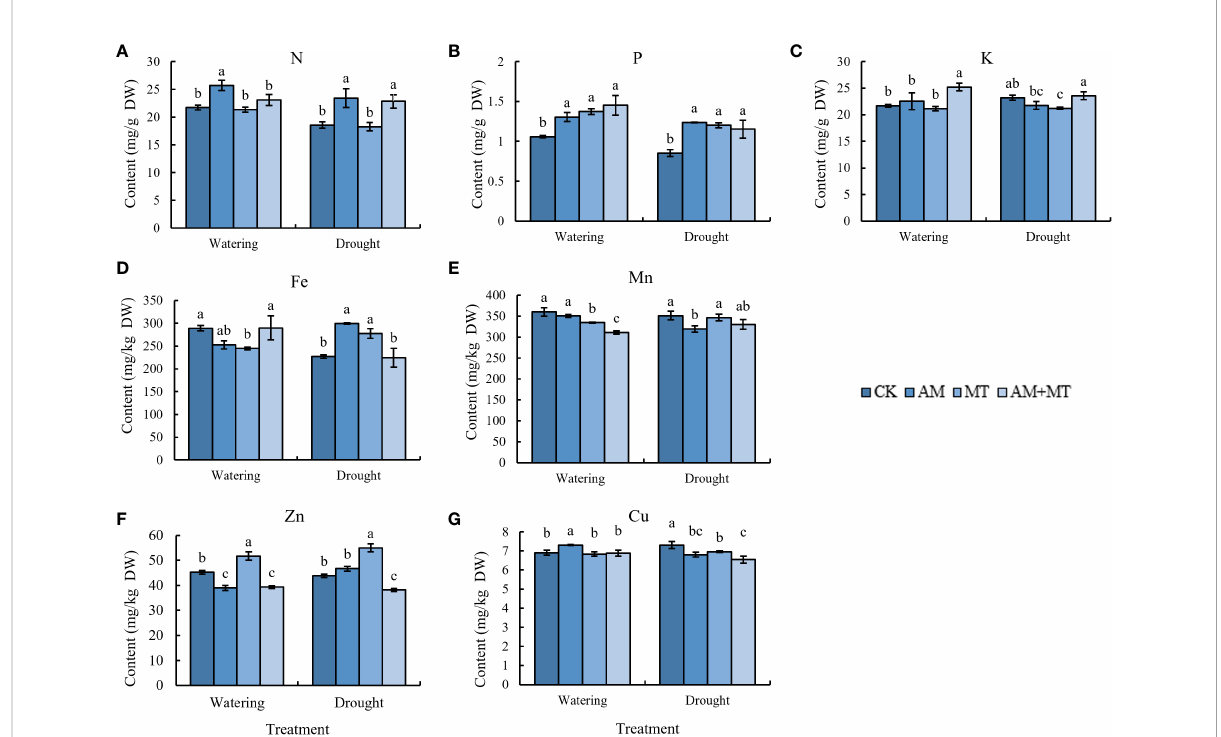
FIGURE 8 Content of N (A) , P (B) , K (C) , Fe (D) , Mn (E) , Zn (F) , and Cu (G) in leaves of kiwifruit seedling under well-watering or drought stress. Data are presented as meant ± SD ( n = 6), different letters indicate signi fi cant differences between treatments at p < 0.05 by Tukey ’ s Post Hoc test. Treatments included CK (the control), AM (inoculated with arbuscular mycorrhiza), MT (irrigated with 100 m M melatonin), and AM+MT (treated with melatonin and arbuscular